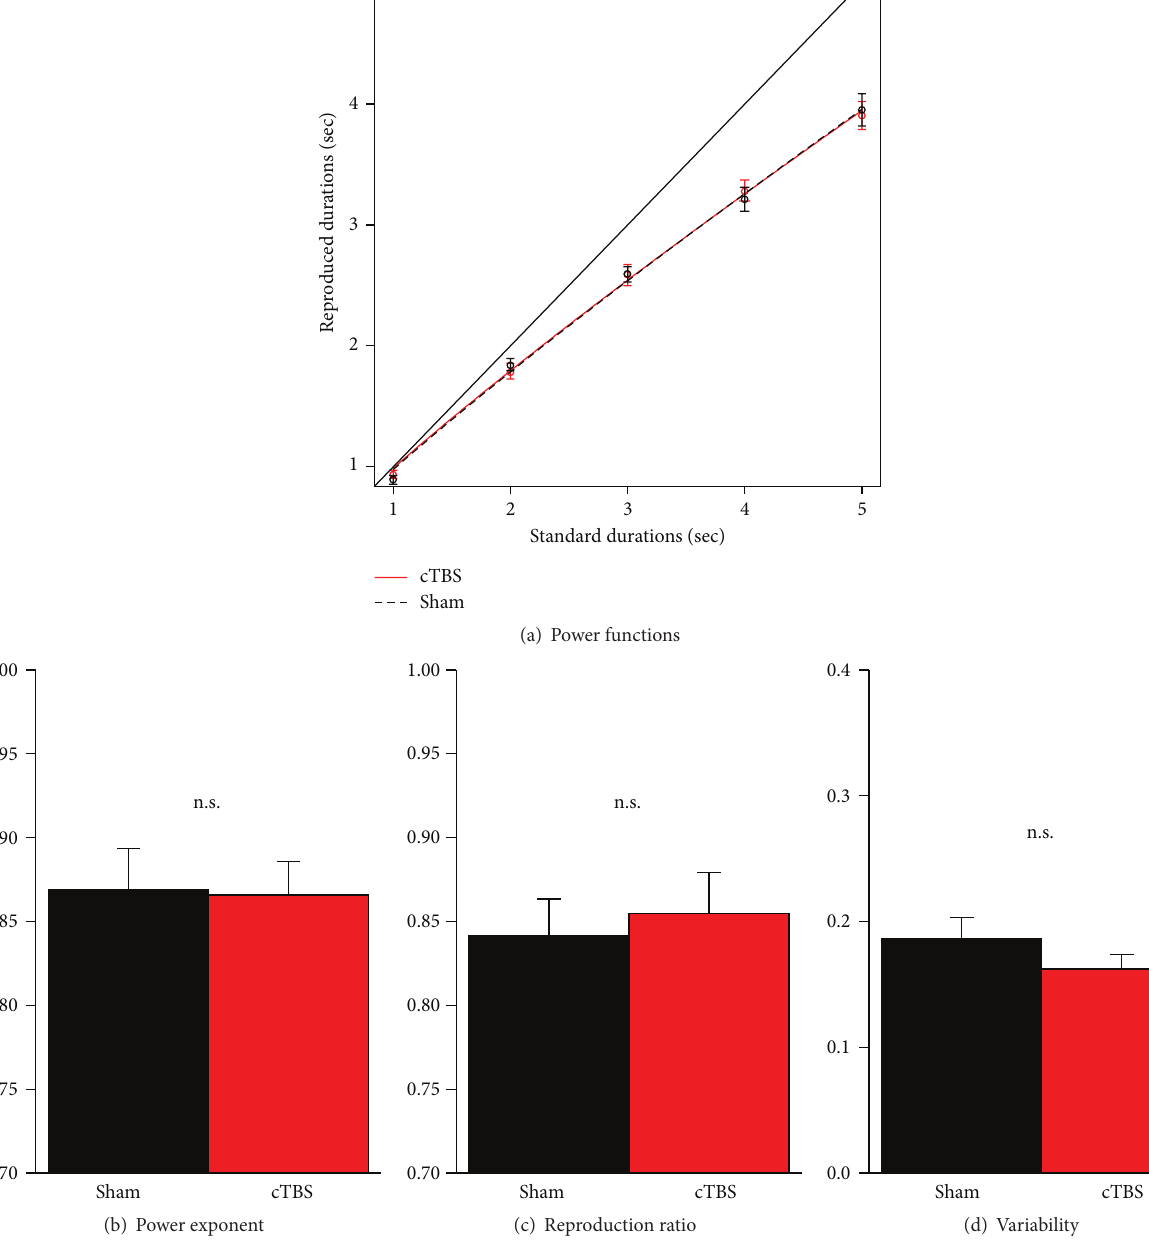
Figure 4: (a) Averaged power functions according to the reproduction data. No differences between cTBS (red bars) and sham stimulation (black bars) were found for the power exponent (b), the ratio between reproduced and standard durations, (c) and response variability (d). Error bars show standard errors of the mean across